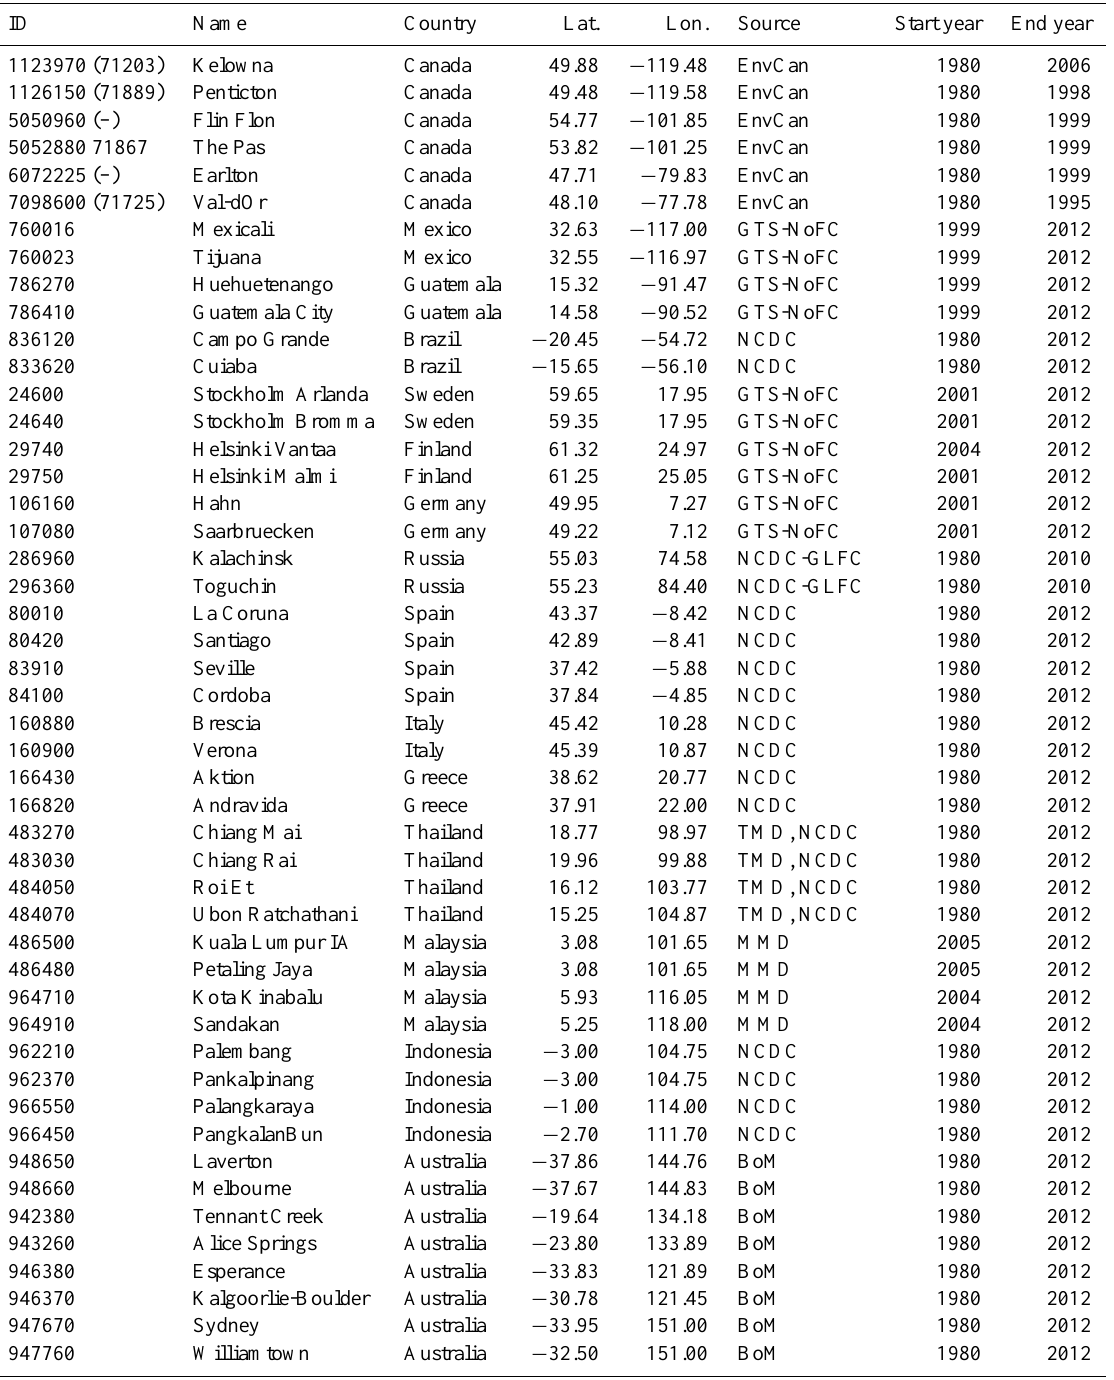
Table 2. Weather stations used for comparison to gridded calculations. Abbreviations are as follows: Environment Canada (EnvCan), Global Telecommunications System (GTS), Canadian Forest Service Northern Forestry Centre (NoFC), National Oceanic and Atmospheric Ad- ministration National Climatic Data Center (NCDC), Canadian Forest Service Great Lakes Forestry Centre (GLFC), Australian Bureau of Meteorology (BoM), Thailand Meteorology Department (TMD), Malaysian Meteorological Department (MMD). Environment Canada